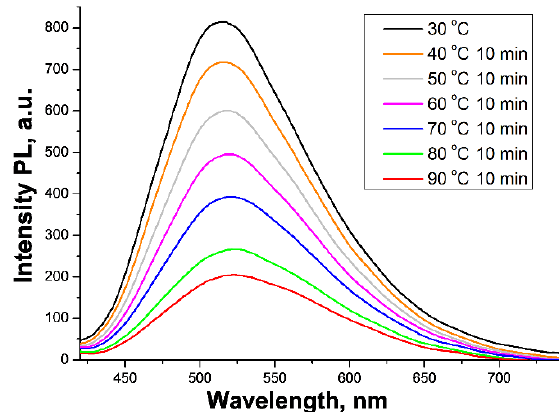
Figure 19. PL spectra of hydrophobic BoronLightSil sample during continuous heating with 10 min exposure at different temperatures (λ ext = 365 nm).